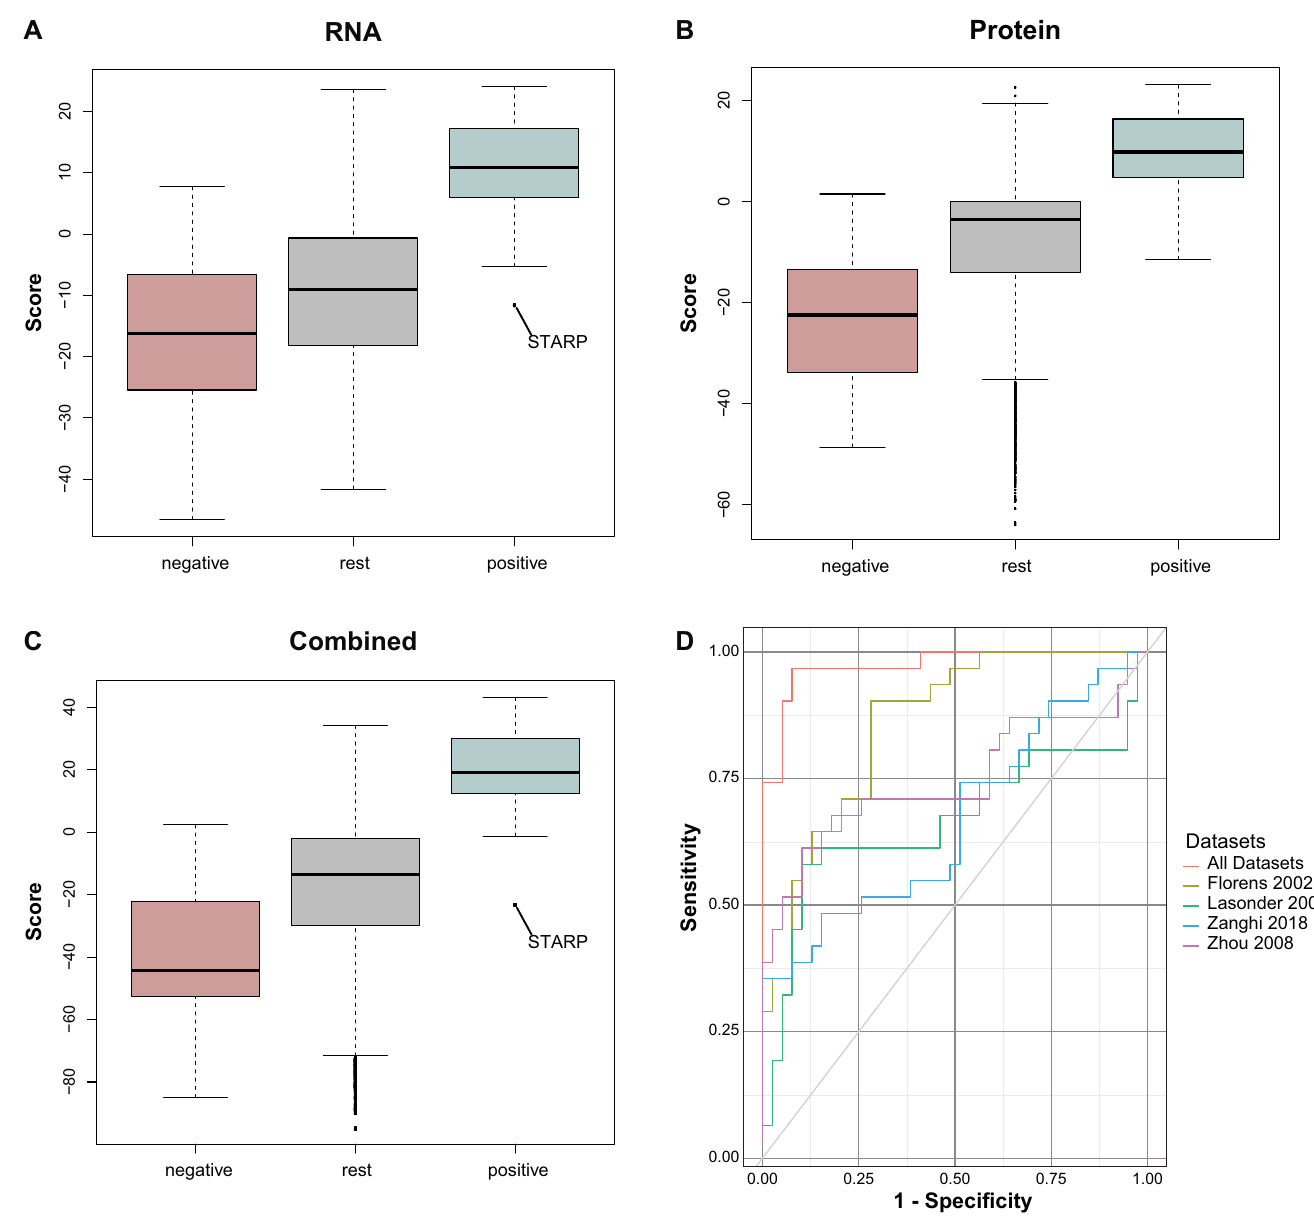
Fig 1. Bayesian data integration identifies sporozoite-specific genes in P . falciparum . Bayesian score distributions of the proteins from the negative gold standard, the positive gold standard and the remaining proteins when the integration is done A) using only RNA data, B) only proteomic data and C) RNAdata plus proteomic data. D) cross validation of our predictions (5-fold cross validation) with all data sets (Black solid line) and predictions with individual data sets (dashed colored